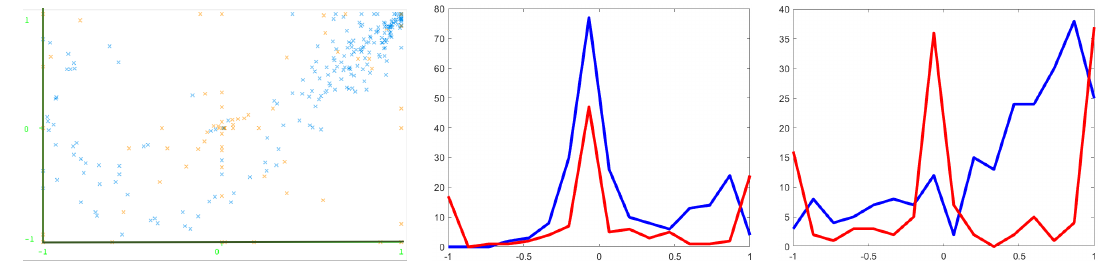
Figure A2. Scatter and Histogram of Ionosphere